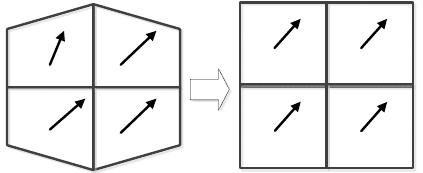
Figure 4. The basic principle of the image deformation process.